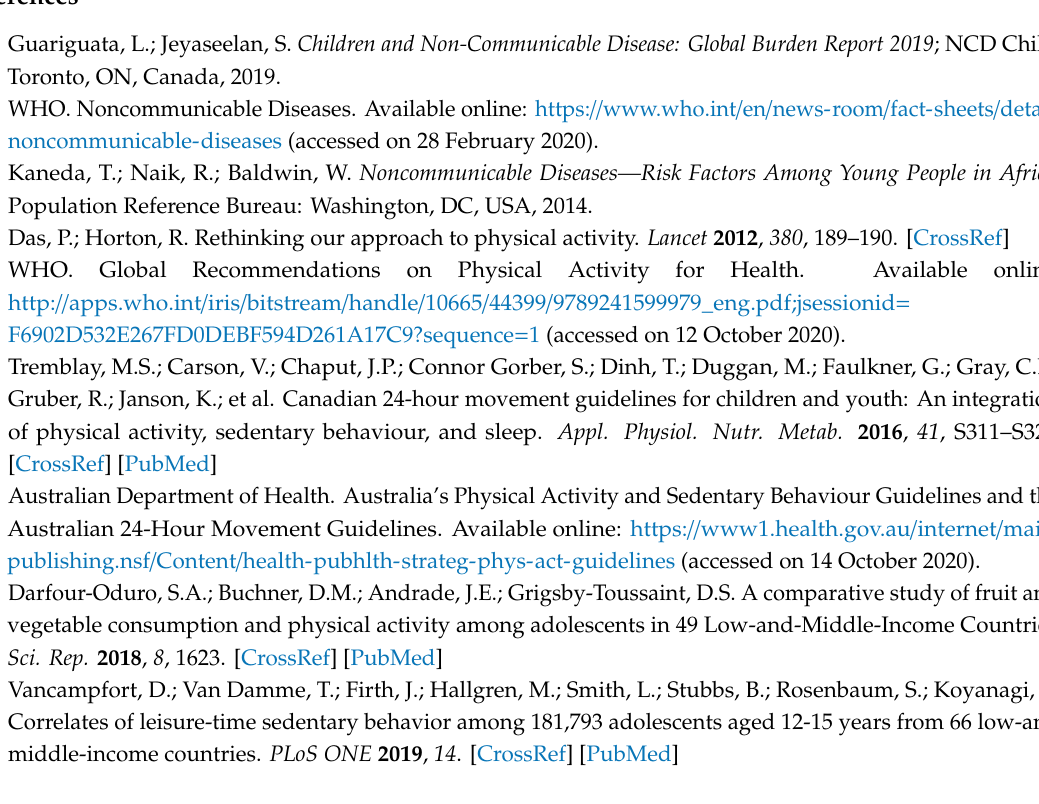
Table S1: PRISMA-ScR Checklist, Table S2: Literature search strategy, Table S3: Data extraction and the references, Table S4: Study topic and subtopic of included studies, Table S5: Summary of research design, Table S6: Characteristics of study